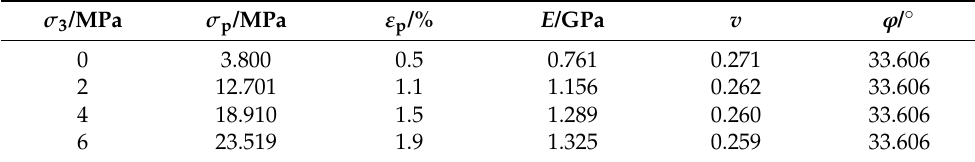
Table 3. Mechanical parameters of red sandstone under 10 freeze-thaw cycles.